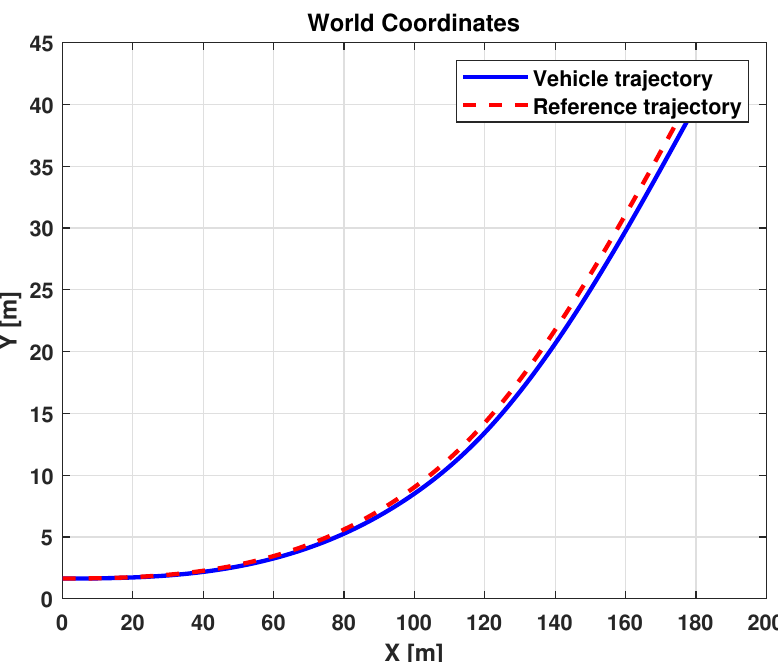
Figure 16. Simulation scenario 1: vehicle and reference trajectories.